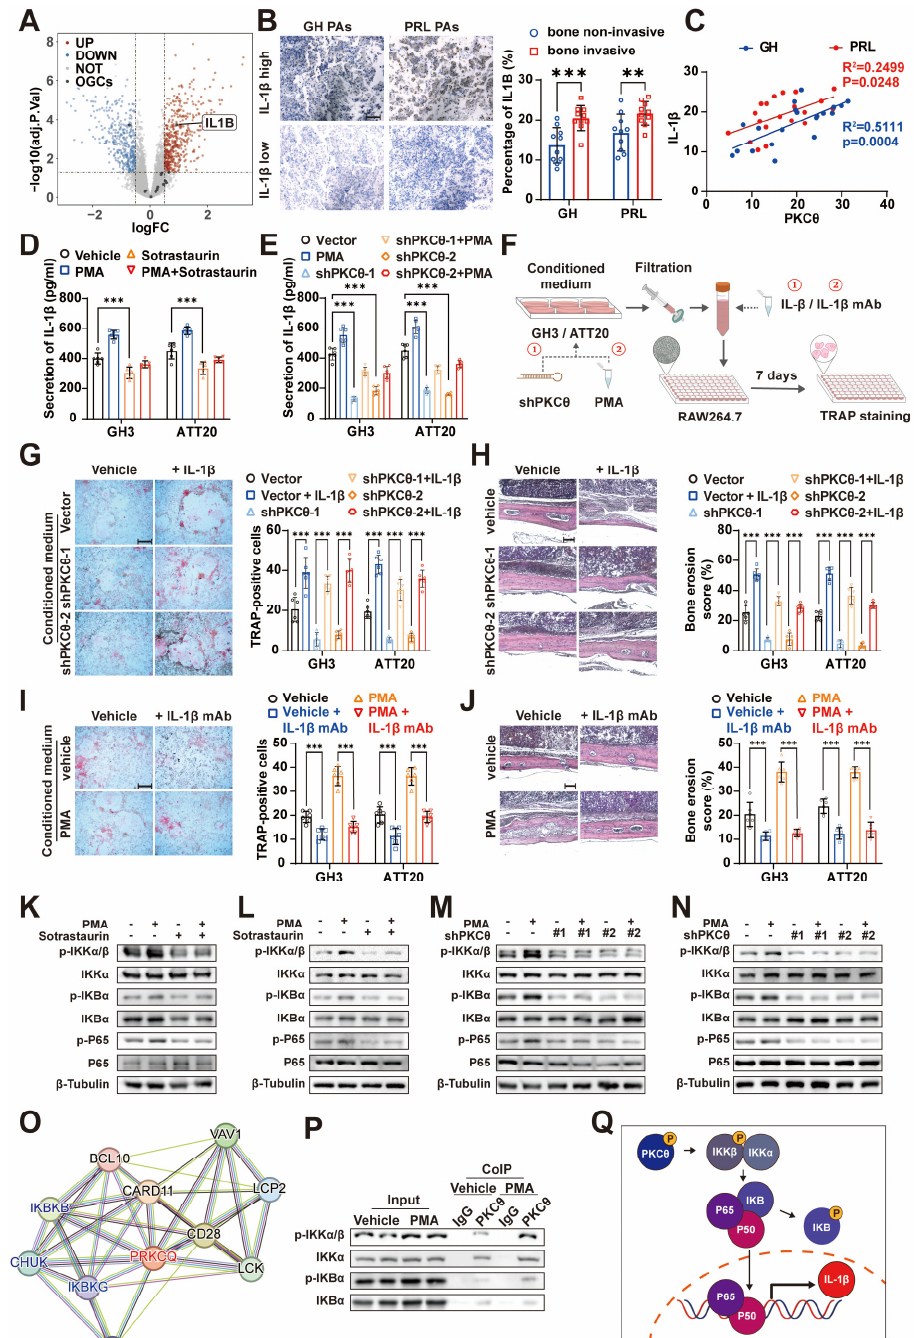
Figure 5. PKC θ releases IL-1 β through activation of NF κ B pathway in PAs. ( A ) Volcano plot showing the distribution of DEGs of osteogenic cytokines in PRKCQ high expression group versus PRKCQ low expression group in PAs (The data analyzed are described in Figure 2A; OGCs, osteogenic cytokines). ( B , C ) Immunohistochemistry for IL-1 β in clinical specimens of GH-PAs ( n = 20) and PRL-PAs ( n = 20) ( B ) ( × 200; scale bar, 100 µ m). Quantification, right (*** p < 0.001; ** p < 0.01). The relevance of expression levels of IL-1 β and PKC θ ( C ). ( D ) ELISA to detect the secretion level of IL-1 β levels of GH3 and ATT20 in treatment with sotrastaurin and PMA ( n = 6 independent experiments; *** p < 0.001). ( E ) ELISA to detect the secretion level of IL-1 β levels of GH3 and ATT20 cells in groups of vector and shPKC θ with PMA ( n = 6 independent experiments; *** p < 0.001). ( F ) Schematic diagram of GH3 or ATT20 CM were administered to induce RAW264.7 differentiation towards